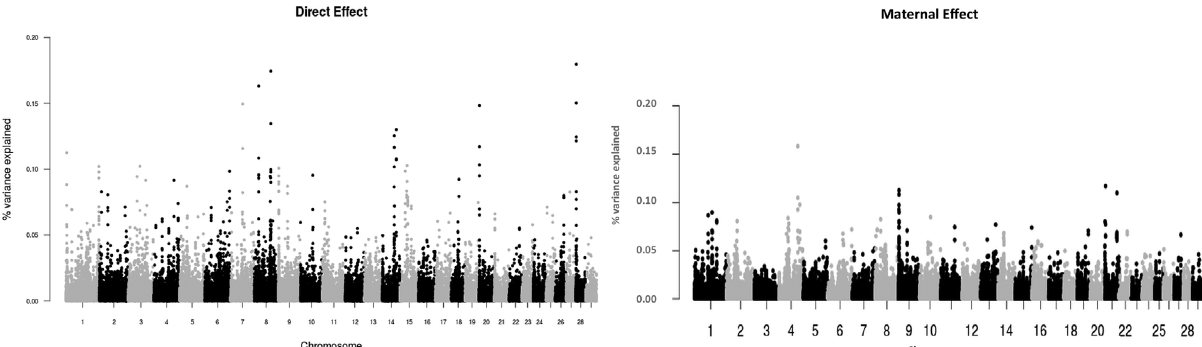
Figure 2 - Manhattan plot for direct and maternal effects for weaning weight at 7 months in Zebu Brahman cattle in Colombia.